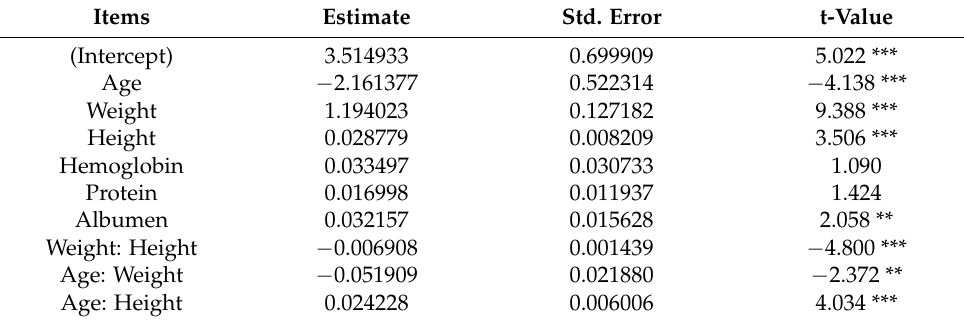
Table 4. Model Estimates for Gaussian Joint-GLM.